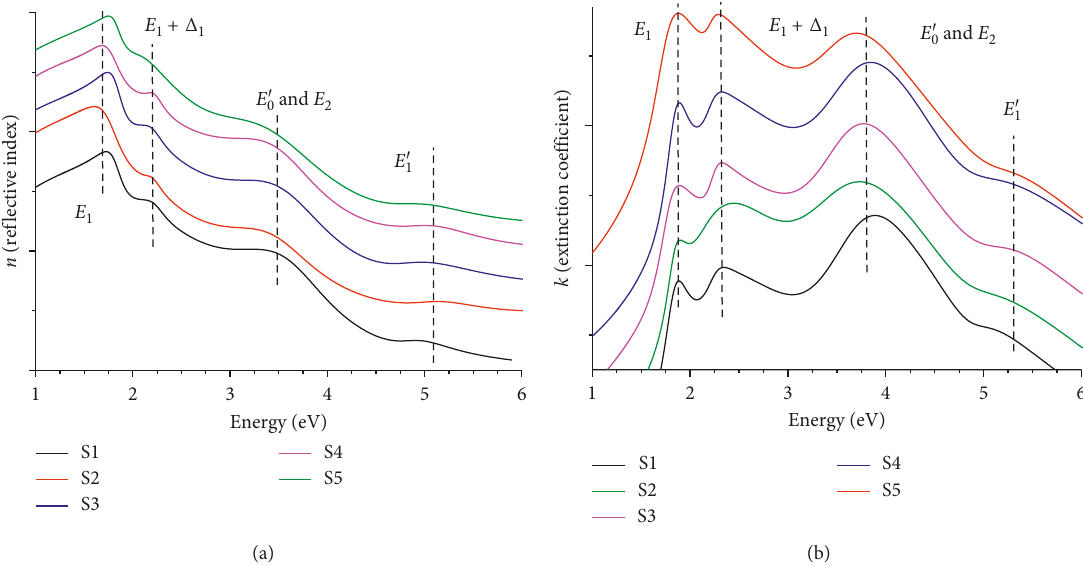
Figure 7: (a) Comparative reflective index ( n ) and (b) comparative extinction coefficient ( k ) for five InSb/GaAs samples, deduced from SE and data in Figure 1. Δ